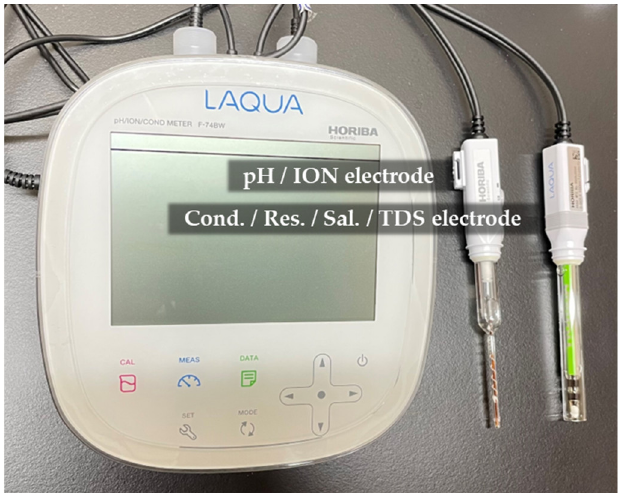
Figure 7. LAQUA Horiba F-74BW meter with pH electrode (left) and electrical conductivity/resistivity/salinity electrode (right).